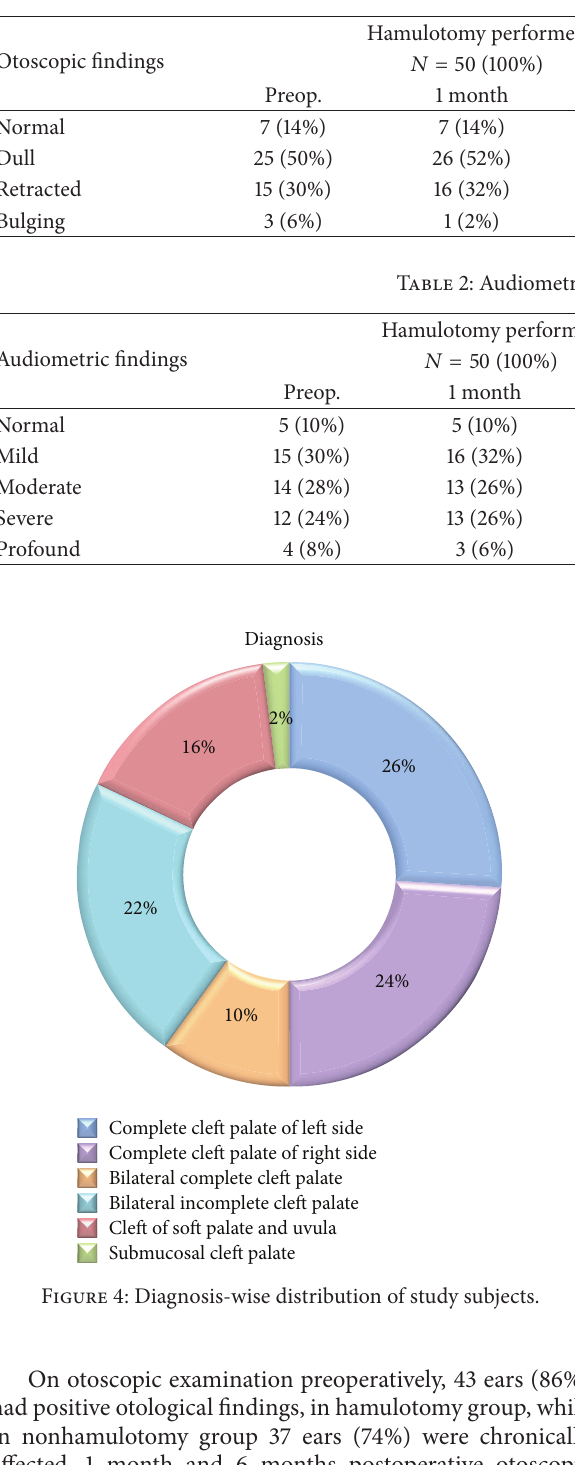
Table 1: Otoscopic findings in study subjects.